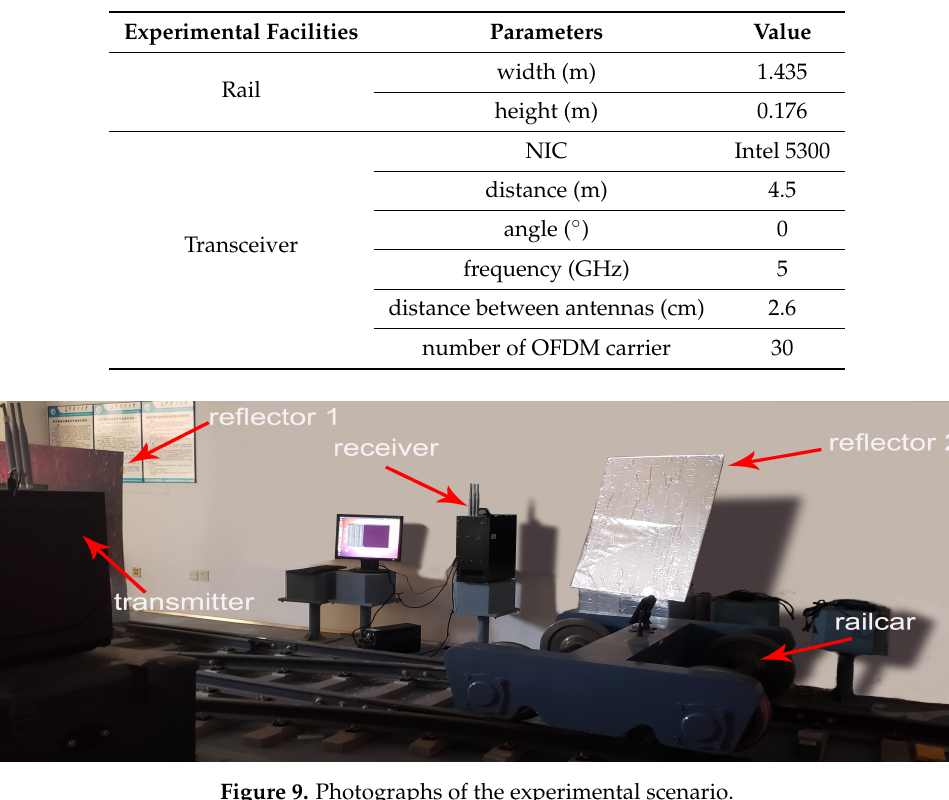
Table 2. Optimal results for two different load cases.